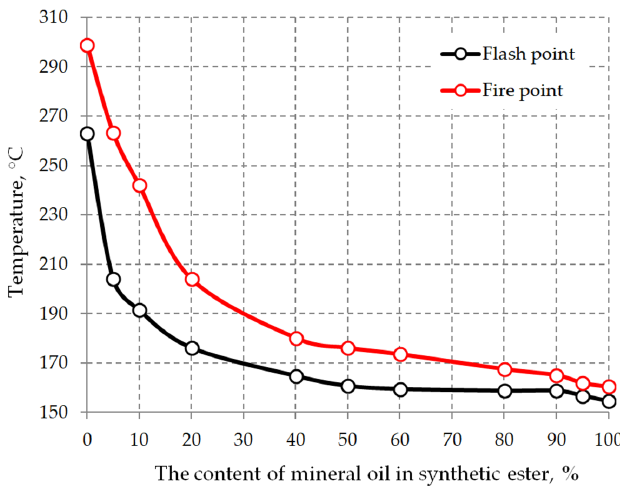
Figure 14. The flash and fire points depending on the content of mineral oil in synthetic ester, on the basis of data from [42].